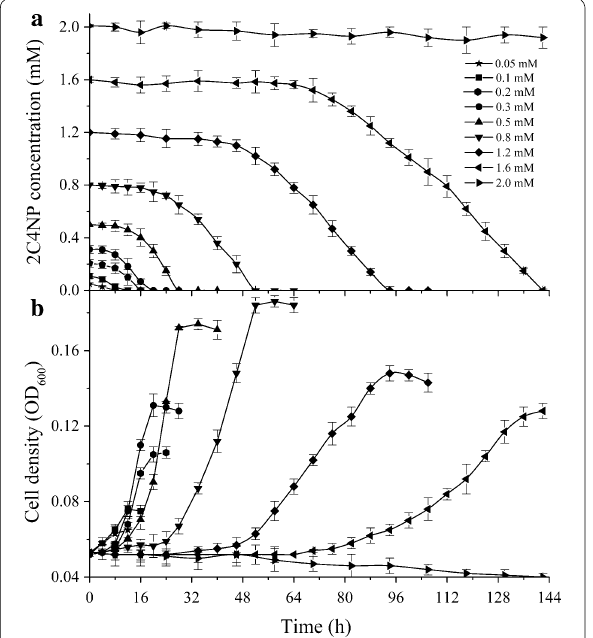
Fig. 2 Biodegradation of 2C4NP ( a ) and growth of strain CNP-8 ( b ) at different 2C4NP concentrations. The experiments were performed in triplicate, and values are mean